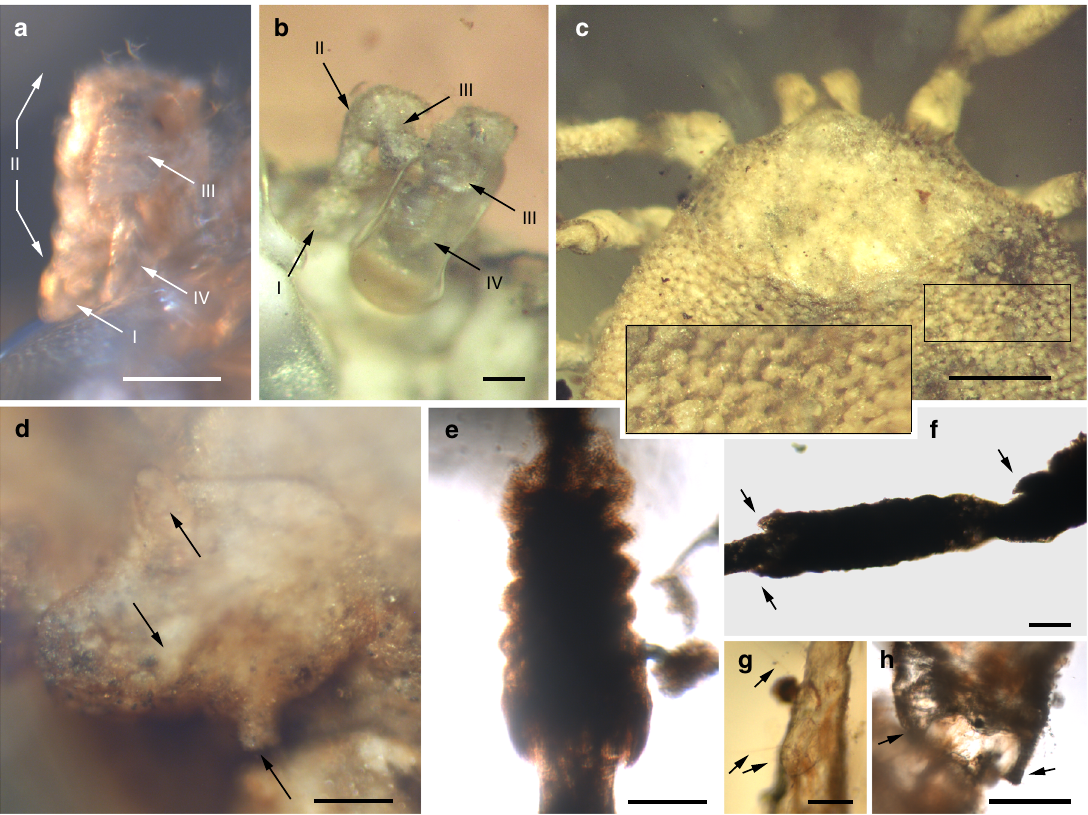
Fig. 4 Photomicrographs showing some anatomical features of the new family Deinocrotonidae. Holotype (AMNH Bu-SA5a) ( a , f , h ); allotype (CM 63007) ( b , c ); paratype male (AMNH Bu-SA5b) ( d , e ). a – b Right palp and right and left palpi in ventral views, respectively, with indication of the number of visible palpomeres. Scale bars, 0.1 mm. c Pseudoscutum and detail of the integument showing mound-like elevations between the pits (see inset). Scale bar, 0.5 mm. d Coxa II showing a row of three spurs (arrows). Scale bar, 0.1 mm. e Ruf fl ed surface of the left genu III. Scale bar, 0.1 mm. f Articulations of the left leg III in ventral view. Note the notch-like processes (arrows). Scale bar, 0.1 mm. g Haller ’ s organ in dorsal surface of the tarsus I (bottom structure is the proximal capsule, in contact with the distal pit). Arrows point to sensilla. Scale bar, 0.05 mm. h Trochanterofemoral articulation of the right leg I. Note the notch-like processes (arrows). Scale bar, 0.1